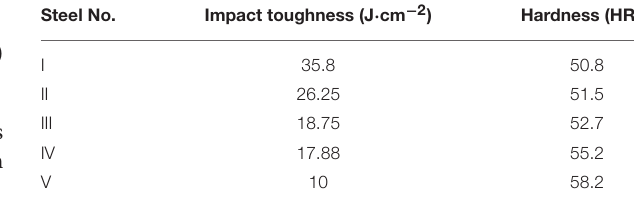
TABLE 2 | Hardness and impact toughness of LAWRCS.